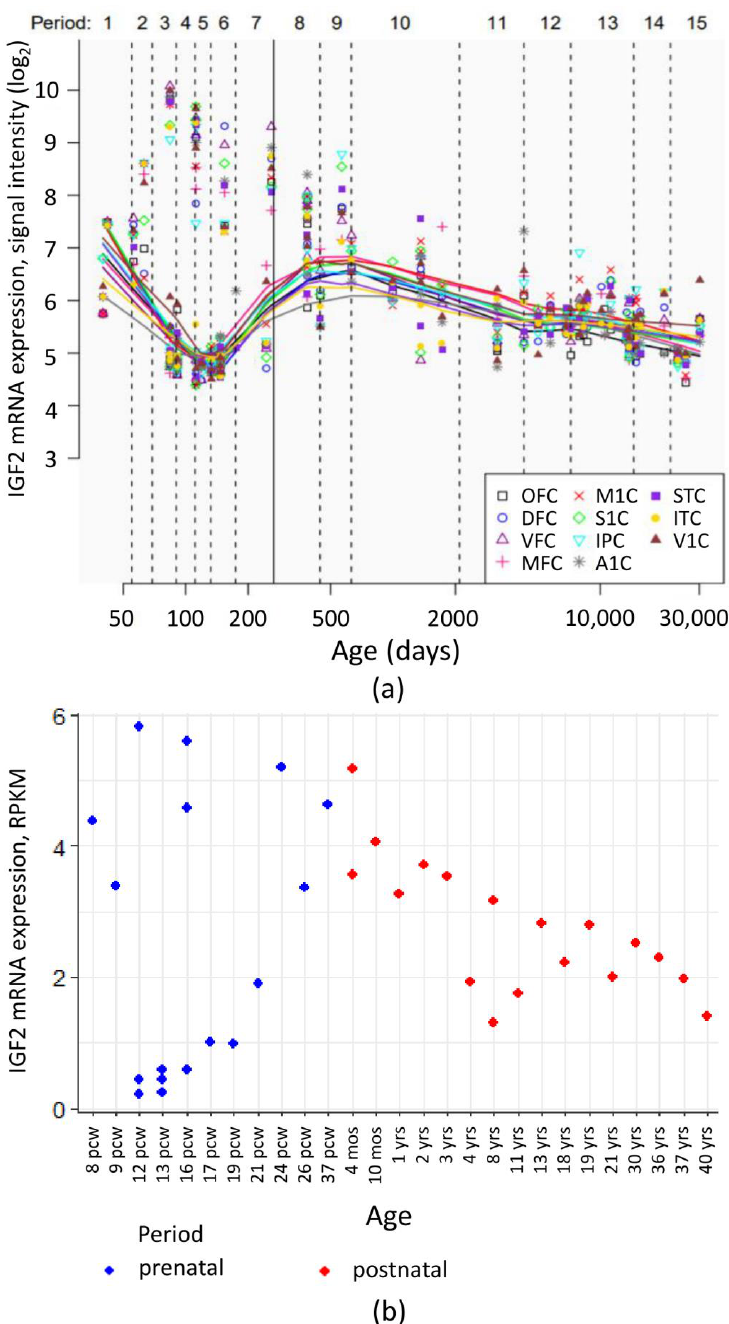
Figure 4. IGF2 mRNA expression levels in human cortical regions during pre- and postnatal development. ( a ) IGF2 mRNA expression levels in neocortical areas assessed in the Human Brain Transcriptome project [76,77]. OFC—orbital prefrontal cortex, DFC—dorsolateral prefrontal cortex, VFC—ventrolateral prefrontal cortex, MFC—medial prefrontal cortex, M1C—primary motor (M1) cor- tex, S1C—primary somatosensory (S1) cortex, IPC—posterior inferior parietal cortex, A1C—primary auditory (A1) cortex, STC—superior temporal cortex, ITC—inferior temporal cortex, V1C—primary visual (V1) cortex. Vertical line denotes the time of birth. Age is given in postconceptional days. ( b ) IGF2 mRNA expression levels (RPKM, reads per kilobase of exon model per million mapped reads) in dorsolateral prefrontal cortex during human development. Image is based on the data obtained from [78,79]. pcw—postconceptional week, mos—months of postnatal development, yrs—donor age in